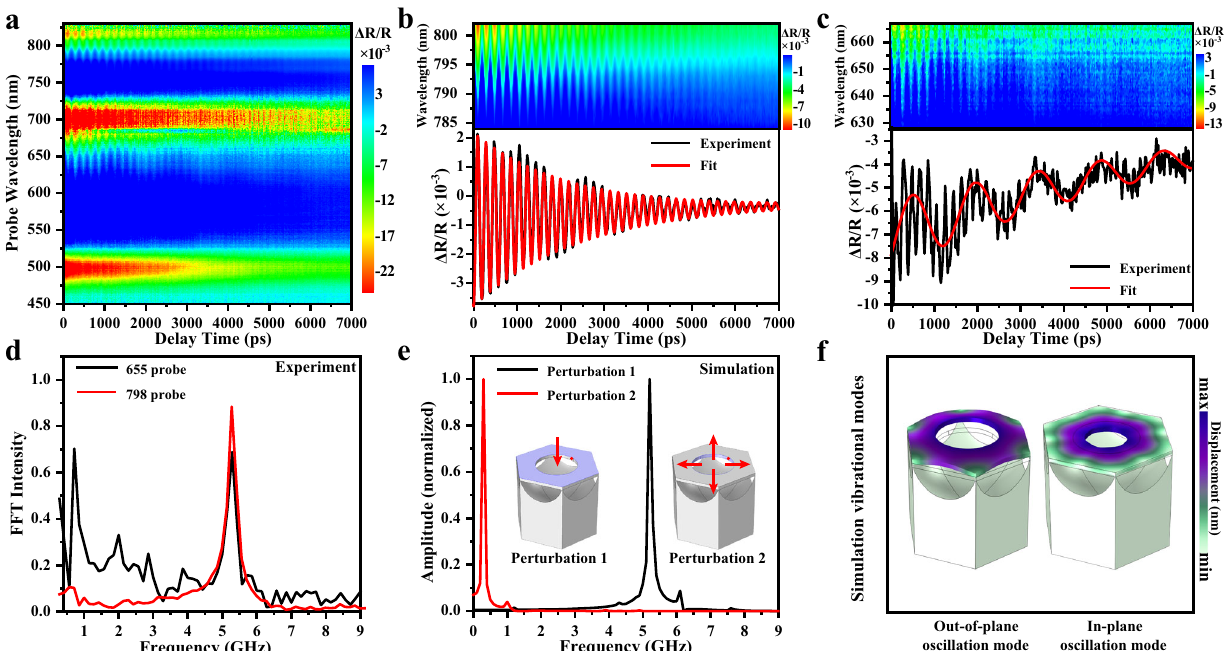
Fig. 2 | Transient optical measurements and simulations. a Transient re fl ection spectralmapoftheTSNOMSforthespectralrangebetween450and830nmwitha delaytimeupto7000ps. b Transientre fl ectionspectralmapforthespectralrange between 785 and 830nm and Δ R/R kinetics at 798nm. c Transient re fl ection spectral map for the spectral range between 630 and 668nm and Δ R/R kinetics at